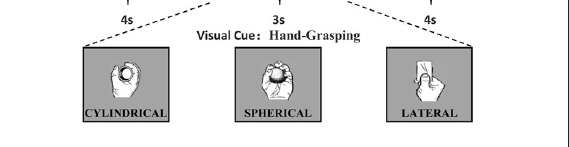
FIGURE1 Experimental paradigm in a single trial and the representation of visual cues according to each task.